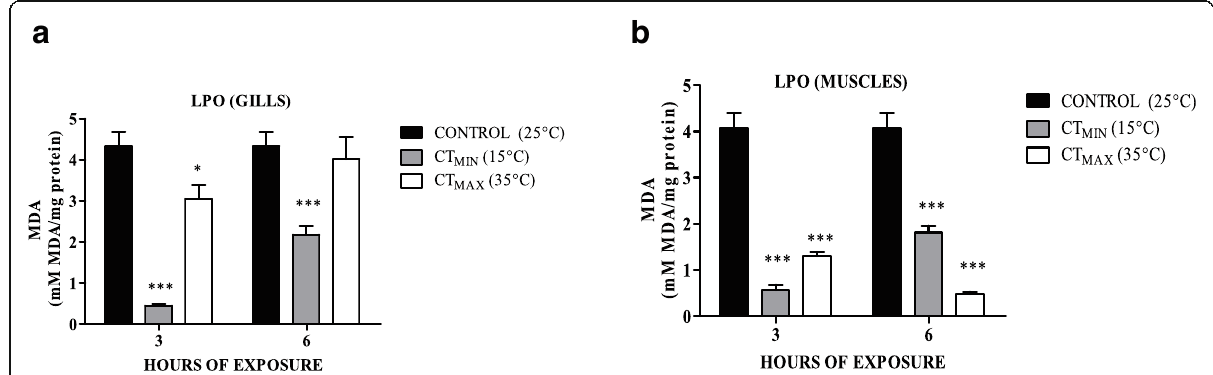
Fig. 1 Effect of temperature on the activity of MDA in the gills ( a ) and muscles ( b ) of Koi carps. Significance was calculated by two-way ANOVA